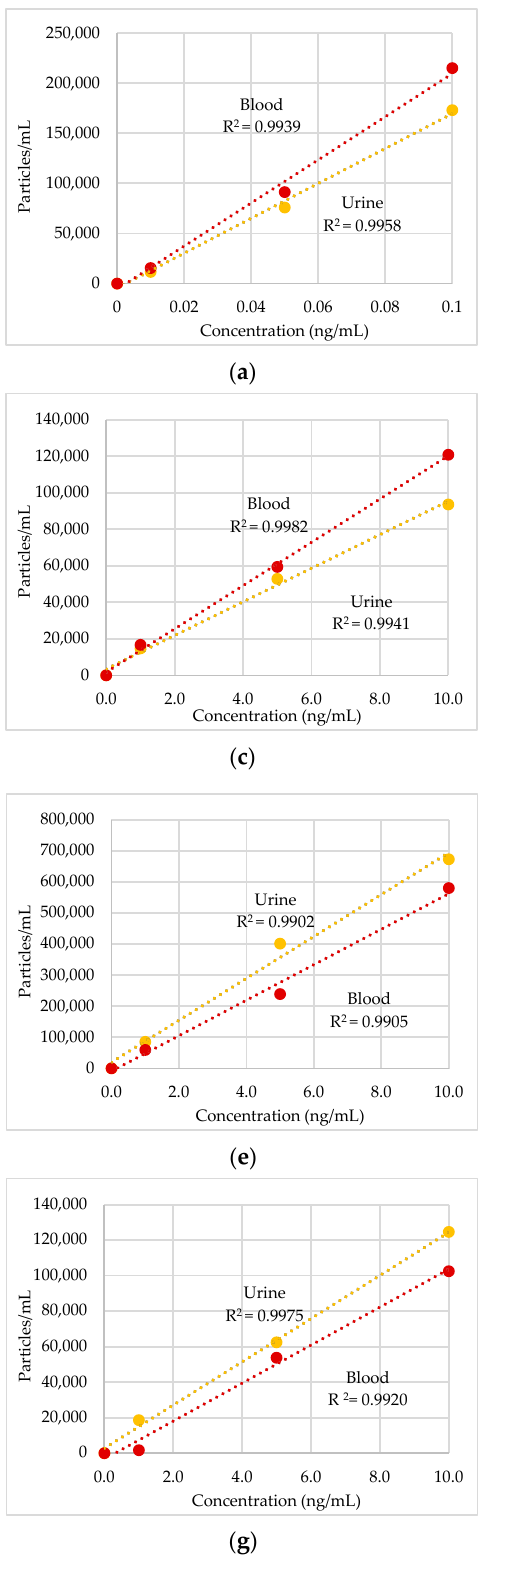
Figure 1. Calibration curves and linear dependence between particles/mL and theoretical concentrations of metal nanoparticles (NPs) reference standard: ( a ) Ag, 40 nm; ( b ) Au, 60 nm; ( c ) In 2 O 3 , 20-70 nm; ( d ) Ir, 15 nm; ( e ) Pd, 15 nm; ( f ) Pt, 15 nm; ( g ) TiO 2 < 100 nm. Table 2. Single Particle-Inductively Coupled Plasma-Mass Spectrometry (SP-ICP-MS) validation study.